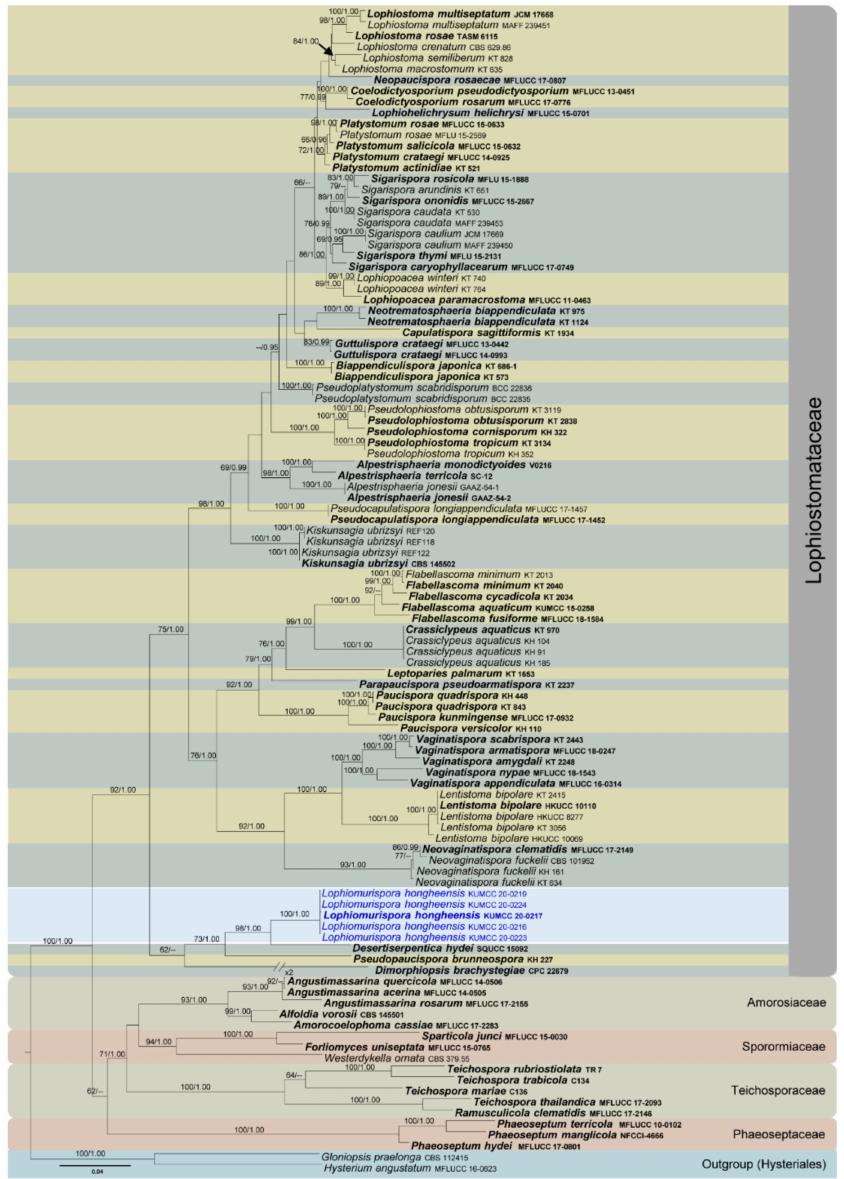
Figure 3. RAxML tree based on a combined dataset of partial SSU, LSU, ITS, tef 1 and rpb 2 DNA sequence analysis in Lophiostomataceae. The tree is rooted to Gloniopsis praelonga (CBS 112415) and Hysterium angustatum (MFLUCC 16-0623). Bootstrap support values for ML equal to or greater than 60% and BYPP equal to or greater than 0.95 are shown as ML/BI above the nodes. Known families and selected genera are indicated with coloured blocks. Blue represents new isolates. The ex-type strains are indicated in bold . The scale bar represents the expected number of nucleotide substitutions per